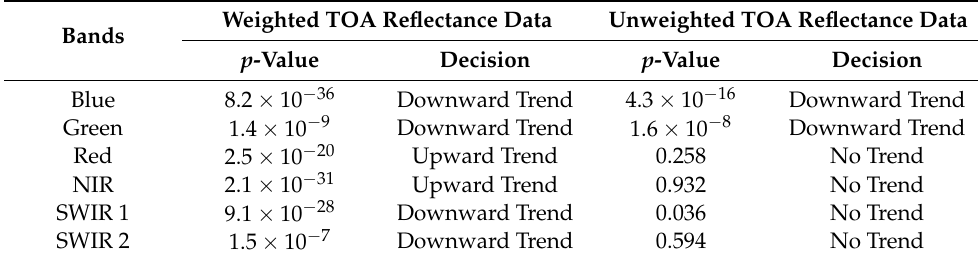
Table 8. Mann–Kendall test results at 0.01 significance level for Sudan 1.